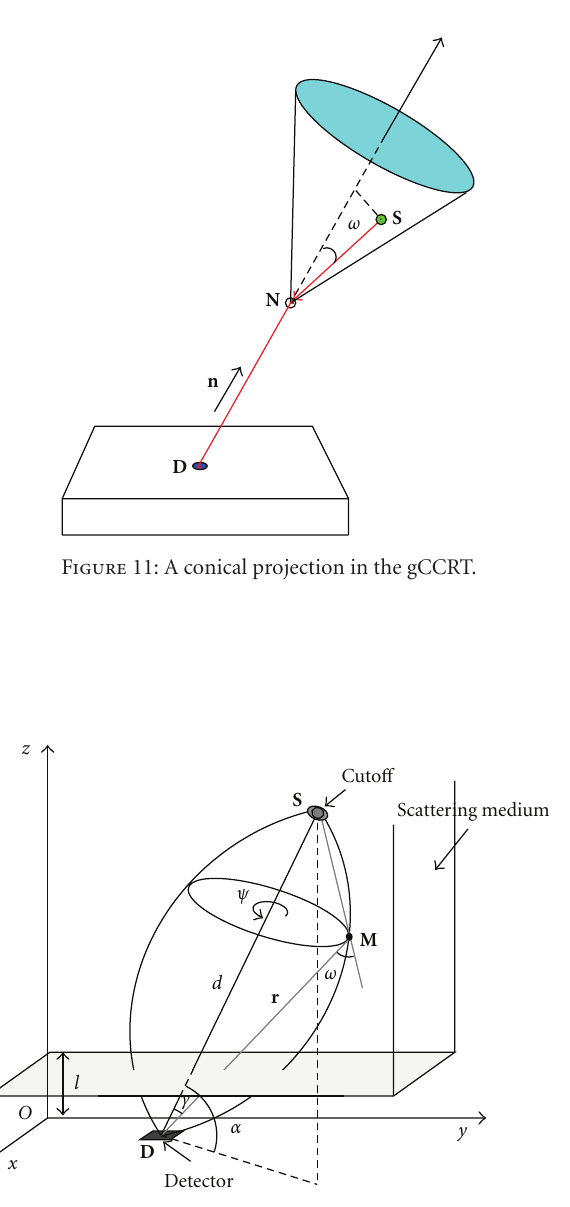
Figure 12: Torus surface of scattering sites for the case without collimator (reprinted with permission from [20]).